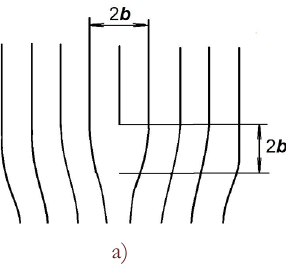
Figure 4: Scheme of minimum inhomogeneity occurring (a) at the dislocation and (b) crack